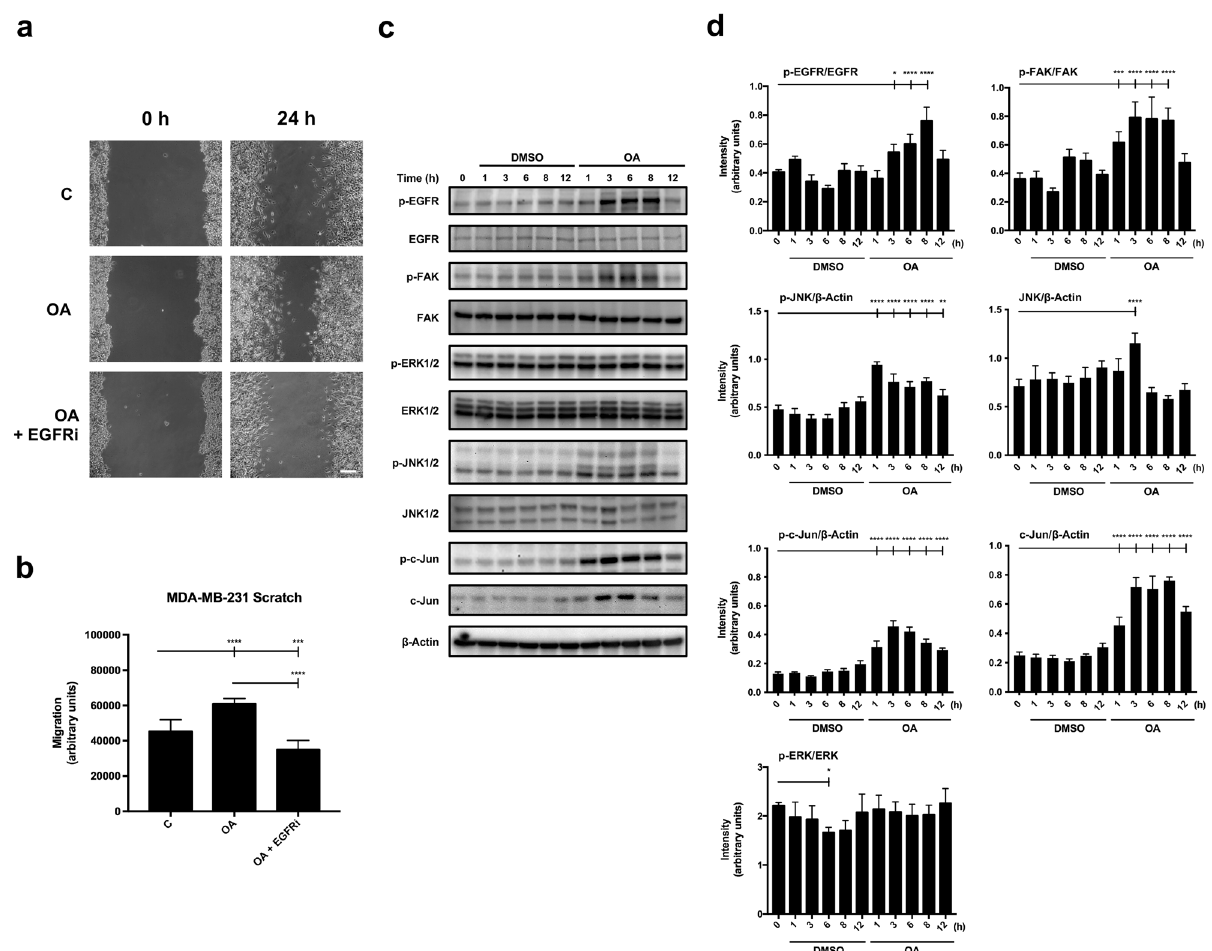
Figure 2. C-Jun and EGFR OA activation, necessary for OA-cell migration, are decoupled in MDA-MB-231 cells. ( a ) The figure shows representative images of cell migration obtained under control conditions compared to those with 10 µM OA and OA plus 2,5 µM EGFRi after 24 h treatment. Scale bar 200 µm. ( b ) Plot represents cell migration as the difference obtained between the quantified areas at time 0 h and time 24 h in each condition. Asterisks indicate statistically significant differences between the selected conditions according to a one-way ANOVA statistical analysis: (*p < 0.05, **p < 0.005, ***p < 0.001 and ****p < 0.0001). ( c ) Total protein extracts from serum-starved sub-confluent MDA-MB-231 cells treated with 10 µM OA, EGF or DMSO equivalent volume as vehicle control. Different proteins were assayed at the indicated times (h) targeting phospho-FAK (Tyr 925), phospho-EGFR (Tyr 1068), phospho-ERK1/2 (Thr 202/Tyr 204), phospho-JNK1/2 (Thr 183/Tyr 185), phospho-c-Jun (Ser 63). Additionally, total protein expression was assayed: EGFR, FAK, ERK1/2, JNK1/2 and c-Jun. β-Actin was used as a loading control. A representative experiment is shown. ( d ) Plots with intensity values of each protein assayed by Western-blot, by gathering the data of three independent experiments. Intensity values were quantified and collected by ImageJ software. Asterisks indicate statistically significant differences between the selected conditions according to a one-way ANOVA statistical analysis: (*p < 0.05, **p < 0.005, ***p < 0.001 and ****p <